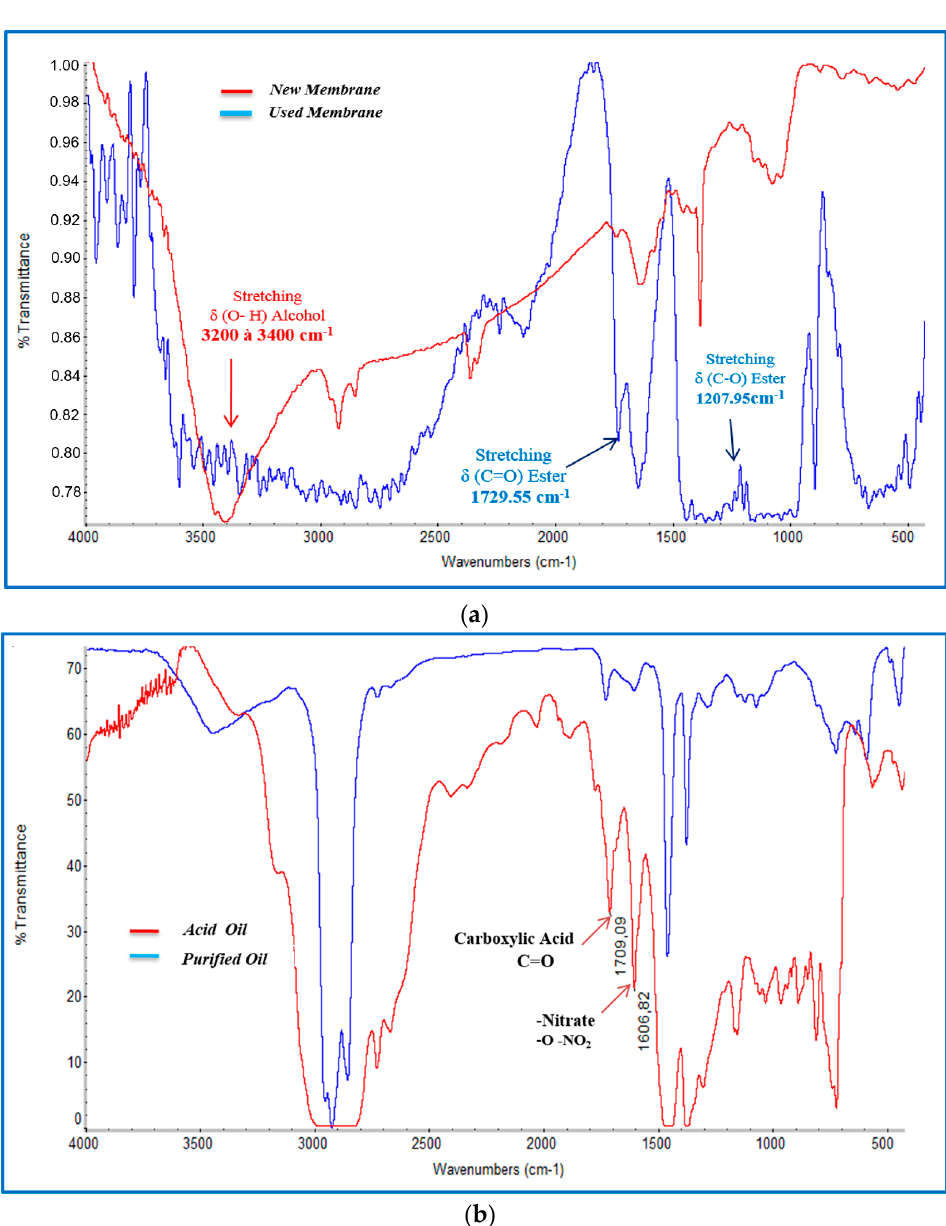
Figure 8. FTIR spectra of oil and membrane for both fresh and used. ( a ) FTIR spectra of new and used membranes. ( b ) FTIR spectra of acidic and treated oil.